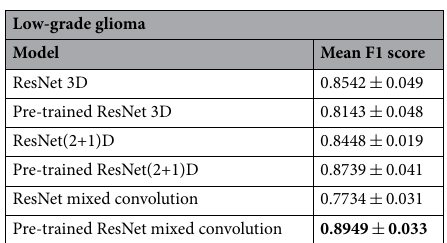
Table 2. Low-grade glioma model comparison (*denotes the overall winning model).